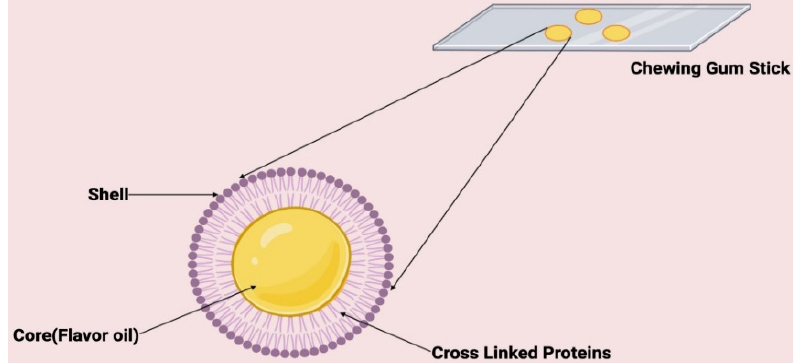
Figure 7. Flavor Microcapsule in chewing gums.